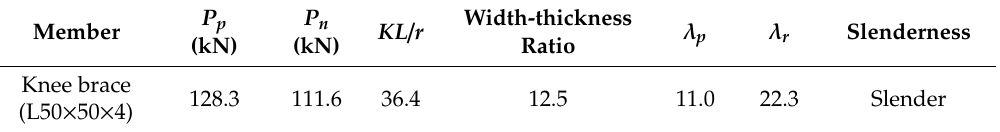
Table 6. Plastic and nominal compressive strength of the knee brace of IC_OB_B specimen.